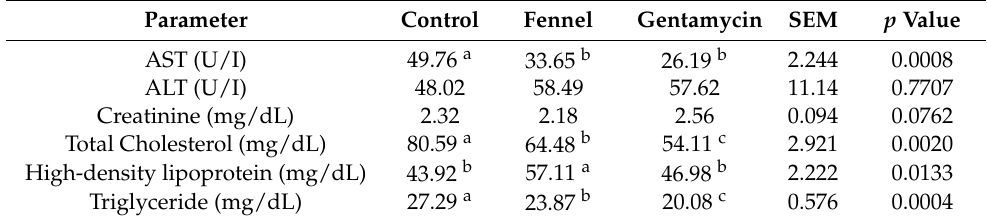
Table 7. Impact of dietary fennel oil or gentamycin on blood biochemical parameters of weaned Moshtohor rabbits aged 12 weeks.